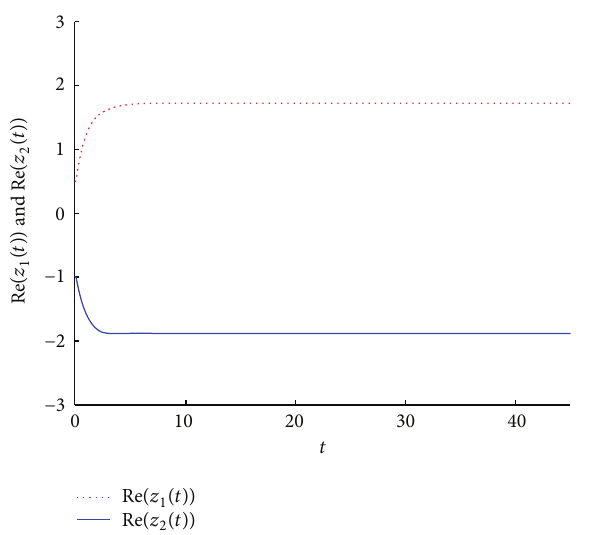
Figure 3: State trajectories of neural network (41).